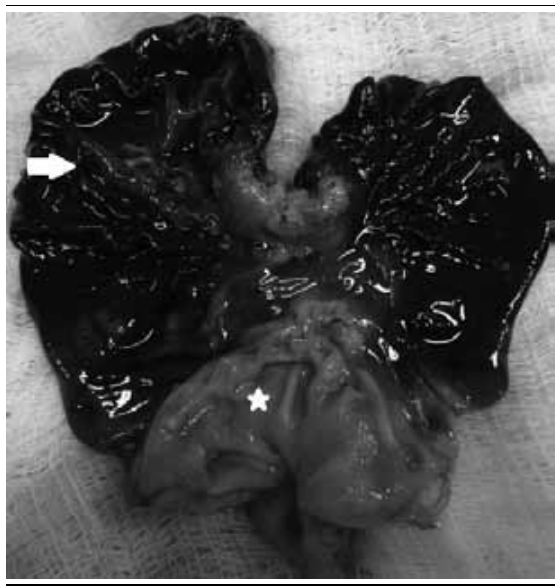
figurE 3 – Macroscopic aspect of the closed stomach of the rabbit after 12 hours of gastric ischemia. The outer surface of the stomach exhibits diffuse hemorrhagic necrosis of the body and fundus regions (arrow), whereas the antropyloric region (*) is preserved